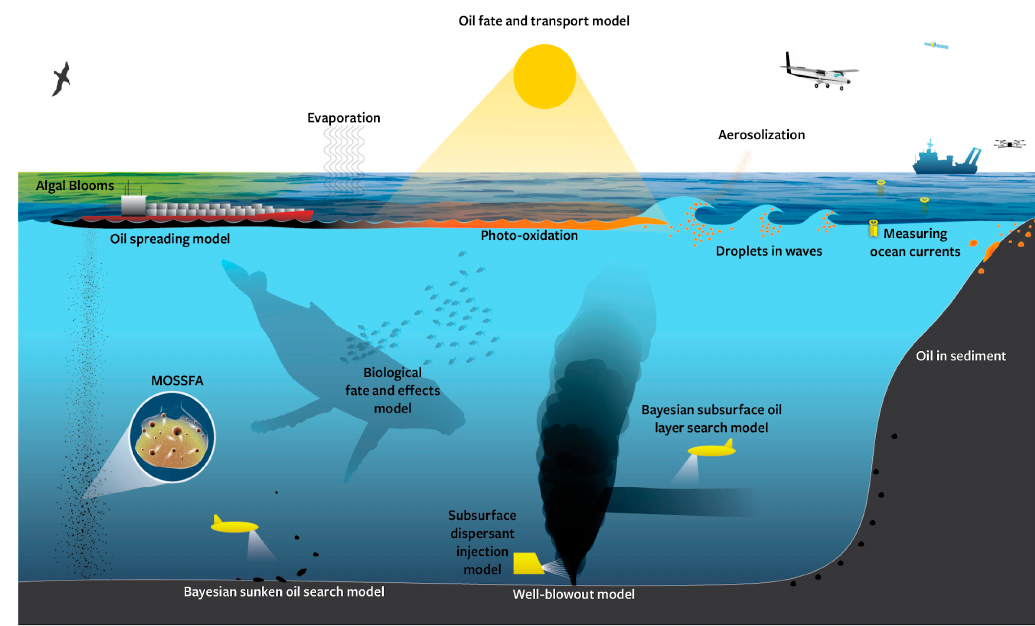
Figure 7. Areas of Gulf of Mexico Research Initiative (GoMRI)-funded research on oil spill